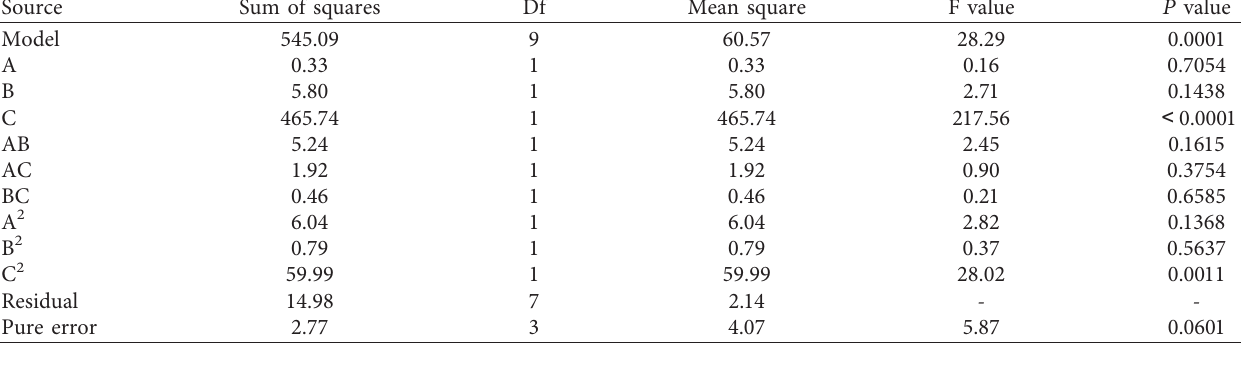
Table 5: Variance analysis of HDFC relative dynamic modulus regression model.